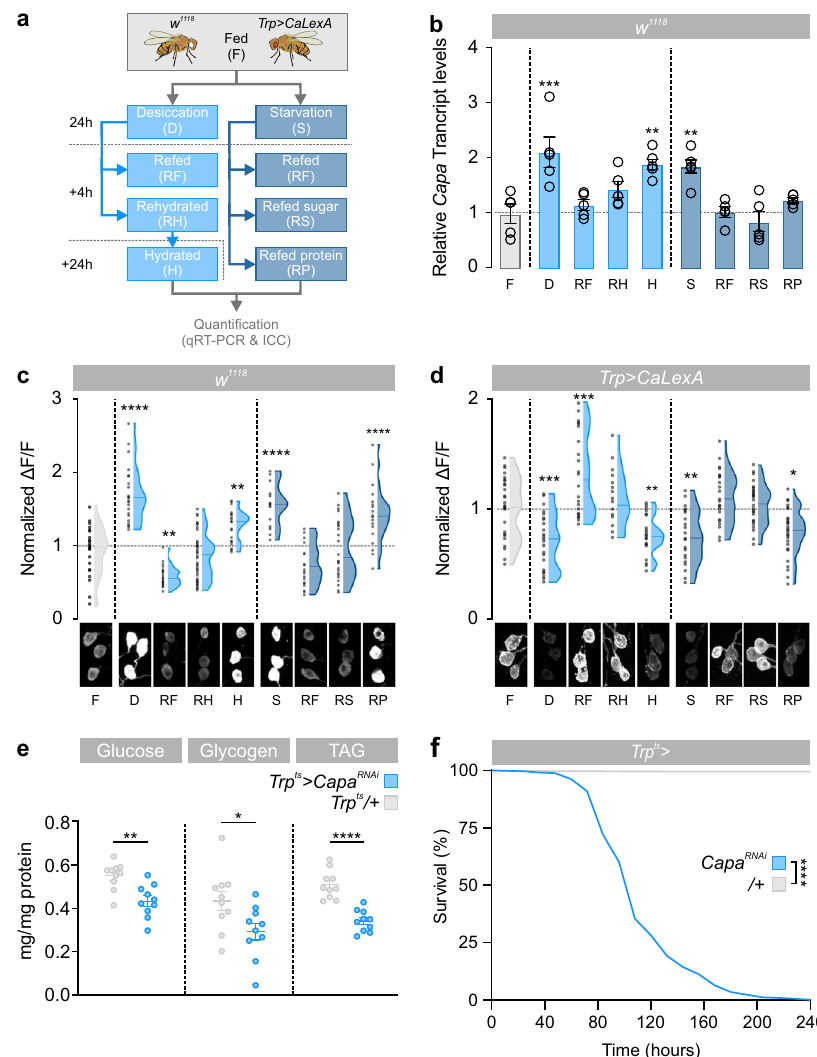
Fig. 7 Environmental cues modulating Capa + Va neuron activity. a Experimental design for the environmental exposures of genetic background control ( w 1118 ) and Trp > CaLexA fl ies. b Transcript levels of Capa gene expression relative to RpL3 in Va neurons (thorax samples) of w 1118 fl ies exposed to the environmental conditions indicated (mean ± SEM; one-way ANOVA; ** P < 0.01; n = 5). c Violin plots and data distributions of immuno fl uorescence quanti fi cations of intracellular Capa precursor levels in w 1118 fl ies (F, n = 23, D, n = 24; RF, n = 24; RH, n = 52; H, n = 29; S, n = 18; RF, n = 24; RS, n = 24; RP, n = 24) and d CaLexA-induced GFP expression (F, n = 30, D, n = 30; RF, n = 24; RH, n = 18; H, n = 24; S, n = 18; RF, n = 30; RS, n = 30; RP, n = 36) in Capa + Va neurons with representative images from all conditions (one-way ANOVA; ** P < 0.01; **** P < 0.0001). e Quanti fi cation of whole animal glucose ( P = 0.0014), glycogen ( P = 0.0292) and TAG ( P < 0.0001) levels following adult-speci fi c Capa knockdown ( Trp ts > Capa RNAi ; mean ± SEM; two-tailed Student ’ s t -test; n = 10). f Knockdown of Capa in adult fl ies ( Trp ts > Capa RNAi ; n = 347) results in signi fi cant mortality relative to parental control ( Trp ts > + ; n = 409) (two-sided log-rank test; P <